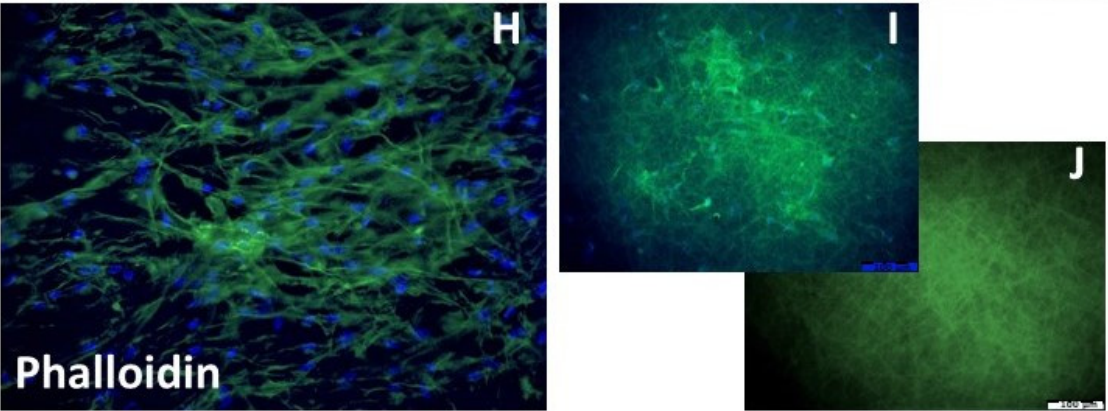
Figure 10. Osteogenic differentiation ability of hDPSCs on PLCL nanofibrous scaffold analyzed by immunohistochemical staining for bone-related proteins expression after osteogenic differentiation. ( A ) strong expression of OCN showed by hDPSC on PLCL in paraffin block section. ( B ) control case negative IHC staining. ( C ) BSP expression in hDPSCs growing on PLCL surface. ( D )